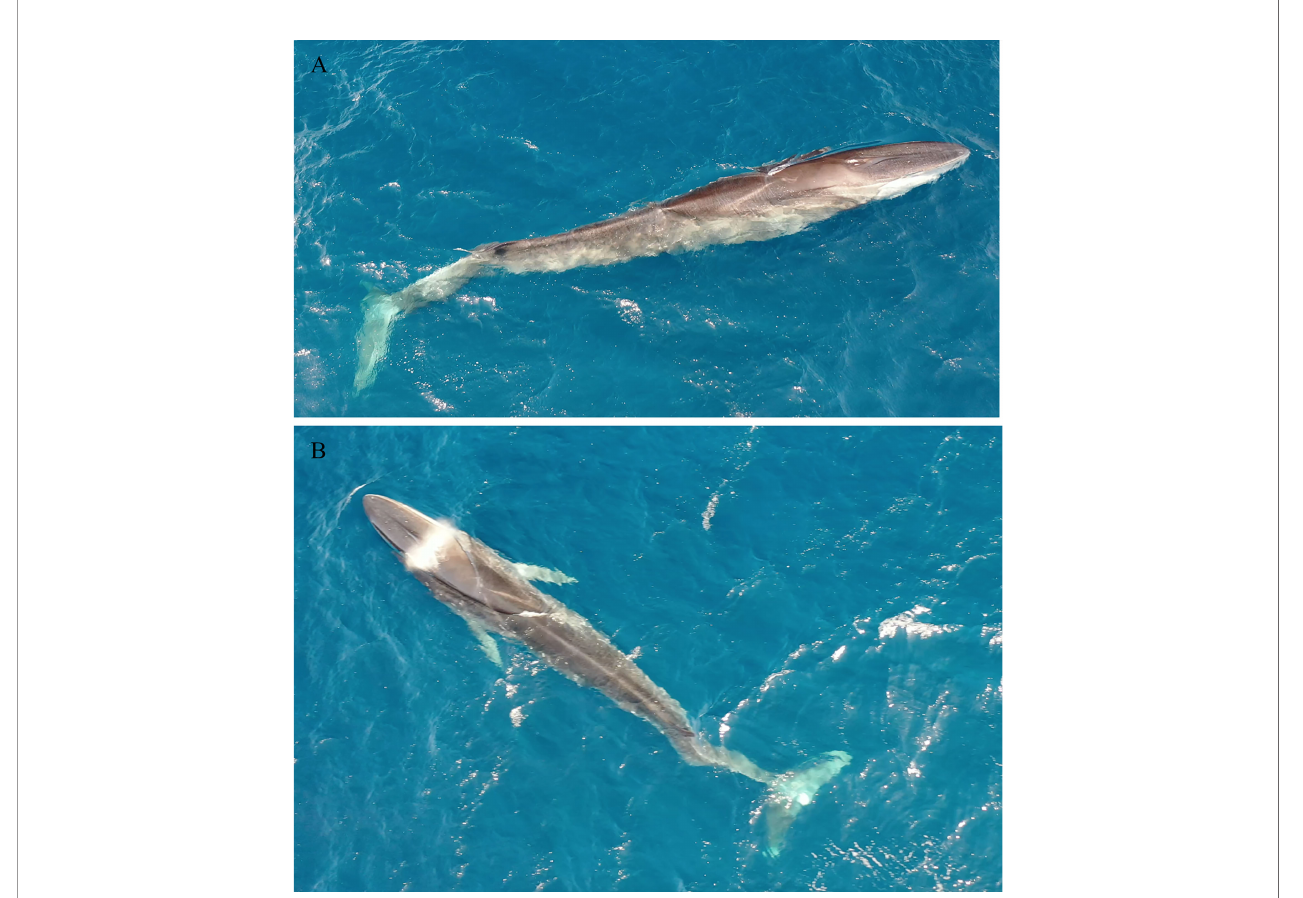
FIGURE 4 | A fi n whale displaying severe damage to its vertebral column and dorsal fi n on 4 April 2021. (A) lateral and (B) overhead view.Photographs by Dr. Eduard